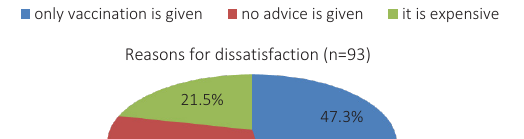
Table 9. Sources of Pre-travel Health